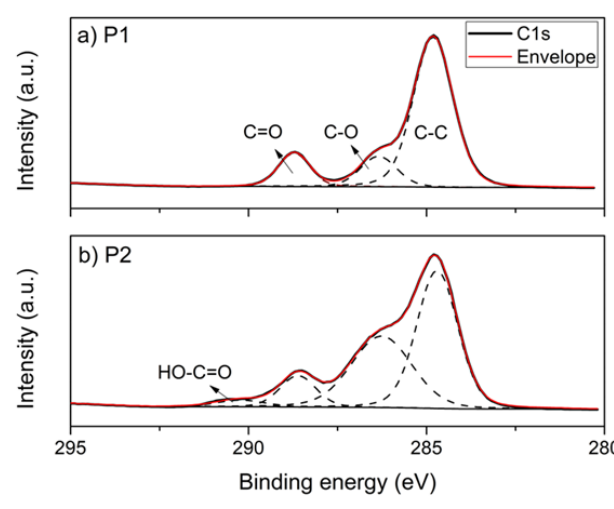
Figure 2. Resolved XPS spectra of C(1s) for ( a ) P1 and ( b ) P2.